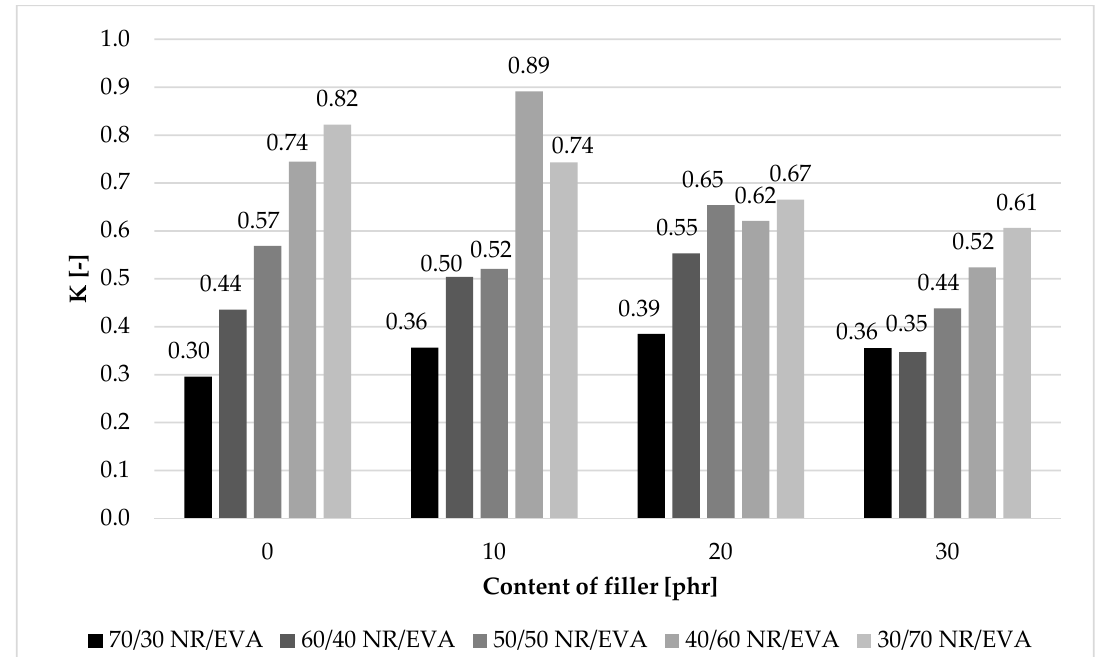
Figure 2. The thermo-oxidative aging factor of blend natural rubber/ethylene–vinyl acetate copolymer Figure blends.